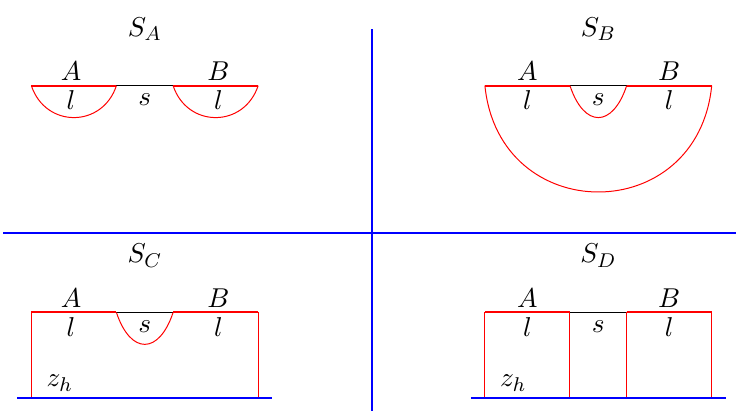
Figure 2 . Pictorial representation of the four different minimal surface configurations in the bulk for a bipartite configuration having two slabs of equal width l separated by a distance s .